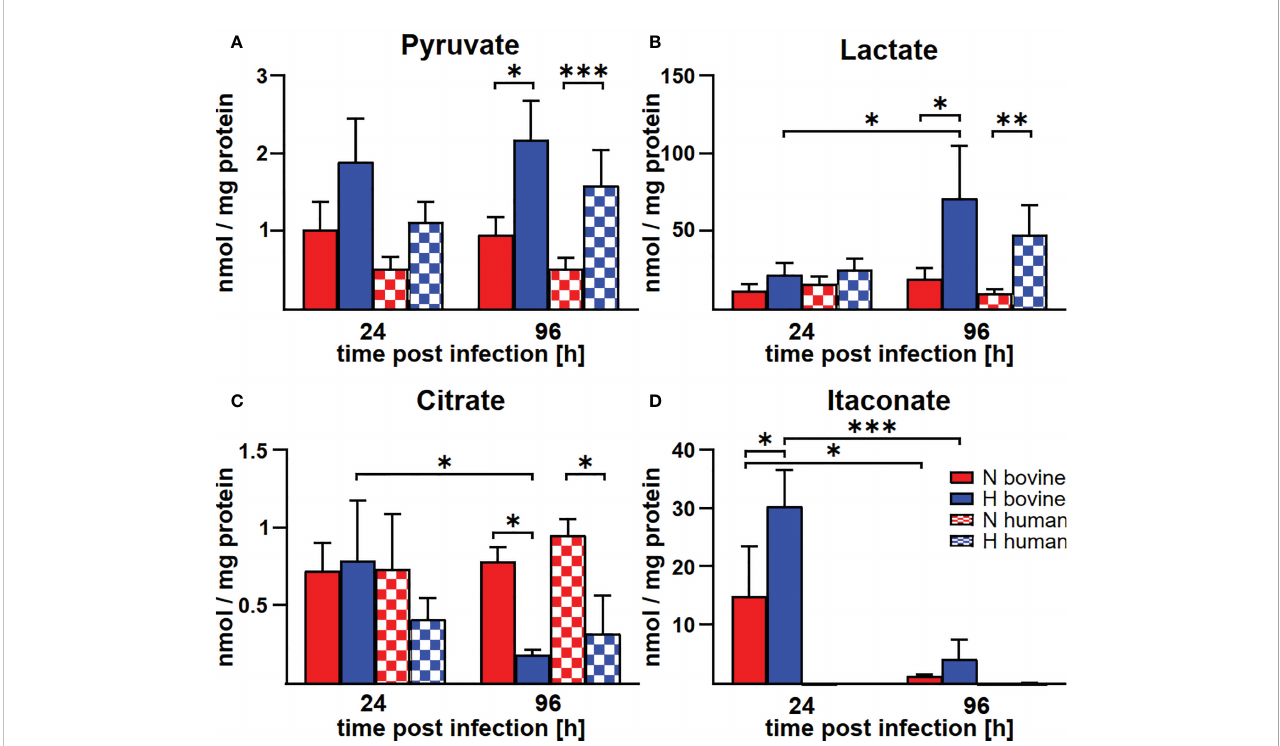
FIGURE 6 Hypoxia alters metabolite concentrations in C. burnetii -infected human and bovine macrophages similarly, with the exception of itaconate. (A-D) Human and bovine macrophages were infected with C. burnetii NMII for the time periods indicated under normoxia (N) or hypoxia (H). Carboxylic acids were analyzed by GC-MS. The amounts of (A) pyruvate, (B) lactate, (C) citrate, and (D) itaconate respectively, are shown in nmol/mg protein from three to four independent experiments. Mean ± SD, n = 3-4, two-way ANOVA with Tukey ’ s multiple comparison test. ***p<0.001, **p<0.01, *p<0.05.